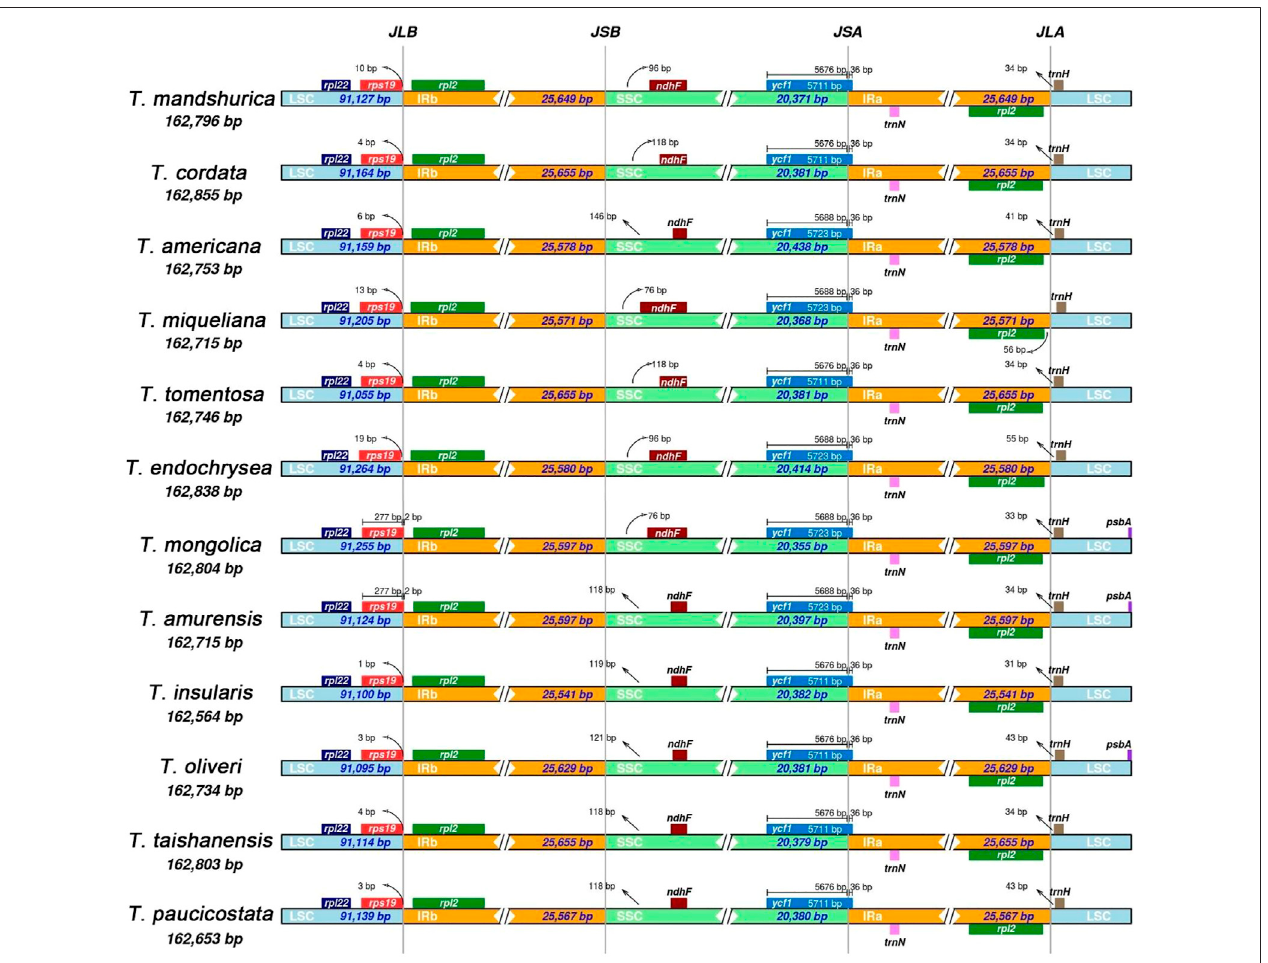
FIGURE 3 | Comparison of the boundaries of large single-copy (LSC), small single-copy (SSC) an inverted repeat (IR) regions of 12 chloroplast genomes of Tilia .